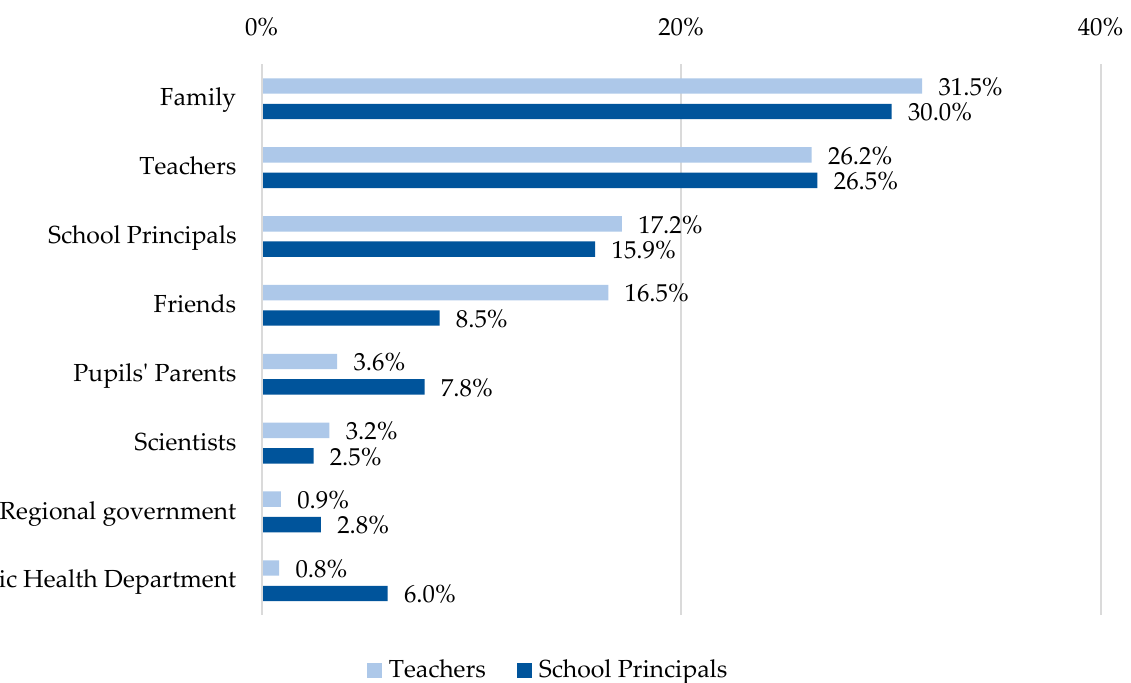
Figure 2. Who do you feel supported by during the pandemic? (Multiple answers possible).